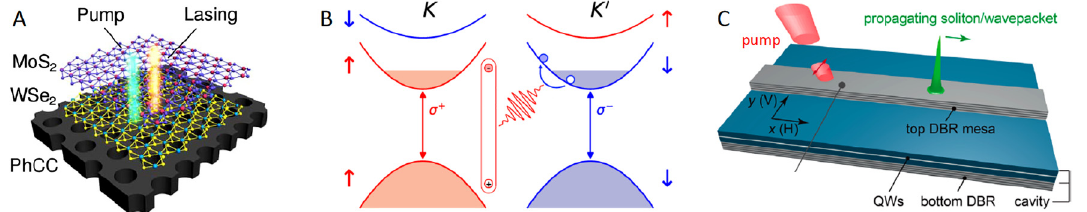
Figure 10: Panel A: schematic of MoS 2 /WSe 2 heterobilayer nanolaser integrated in photonic crystal cavity [402]. Panel B: polaron – polaritons in TMDC semiconductors. Schematic to illustrate the conduction and valence band structure and optical selection rules of monolayer MoSe 2 closetothe K and K ′ points.Anexcitoninthe K valleyinteractswithconductionbandelectron – holepairsintheFermiseaofthe K ′ valleytoform an intervalley polaron. From a study by Bing Tan et al. [468]. Panel C: experimental setup for the exploration of propagating solitons in the system of microcavity exciton polaritons